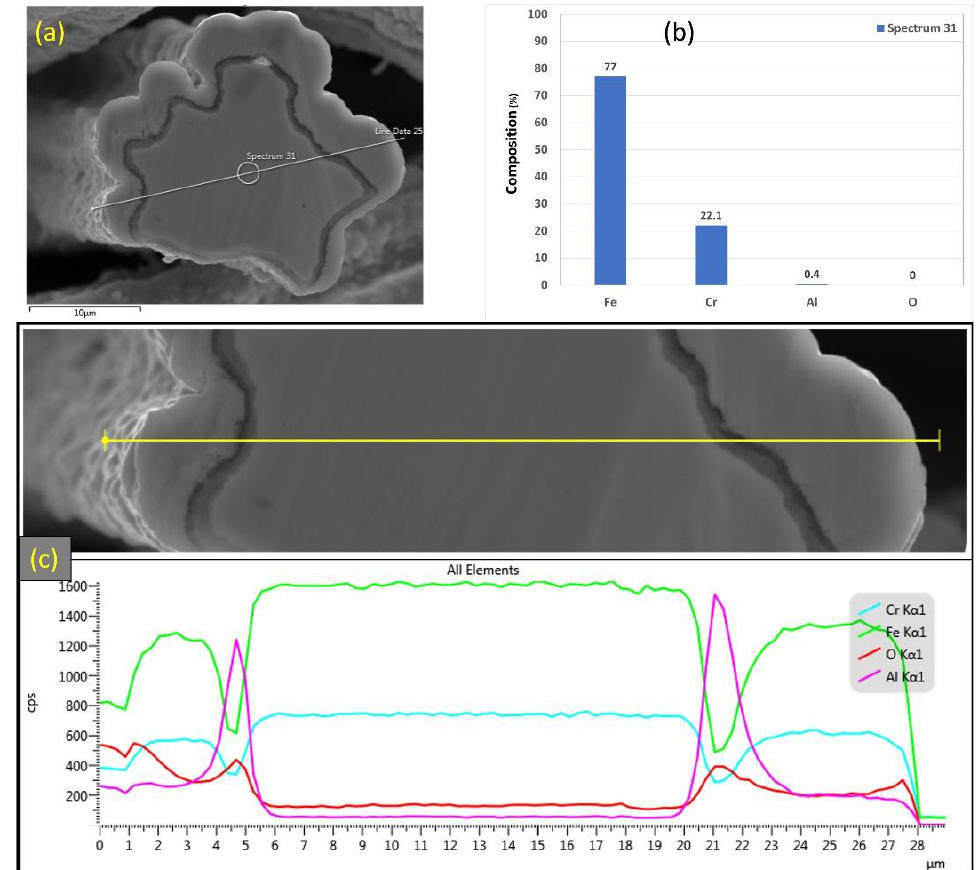
Figure 13. ( a ) SEM micrograph of a cross section of the 12 μ m FeCrAl fiber after 18 MSHT cycles, ( b ) EDS scan at the center of the fiber, ( c ) the characteristic X-ray counts along the specified line scan (Line Data 25) marked in ( a ).